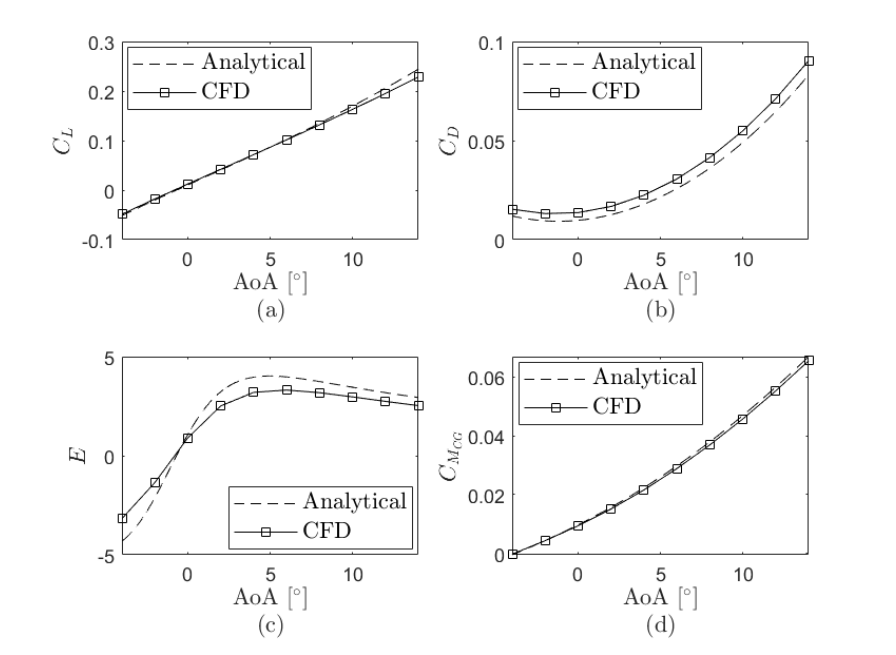
Figure 4. Aerodynamic parameters in terms of the angle of attack (comparison study), ( a ) C L vs. AoA , ( b ) C D vs. AoA , ( c ) E vs. AoA , ( d ) C M